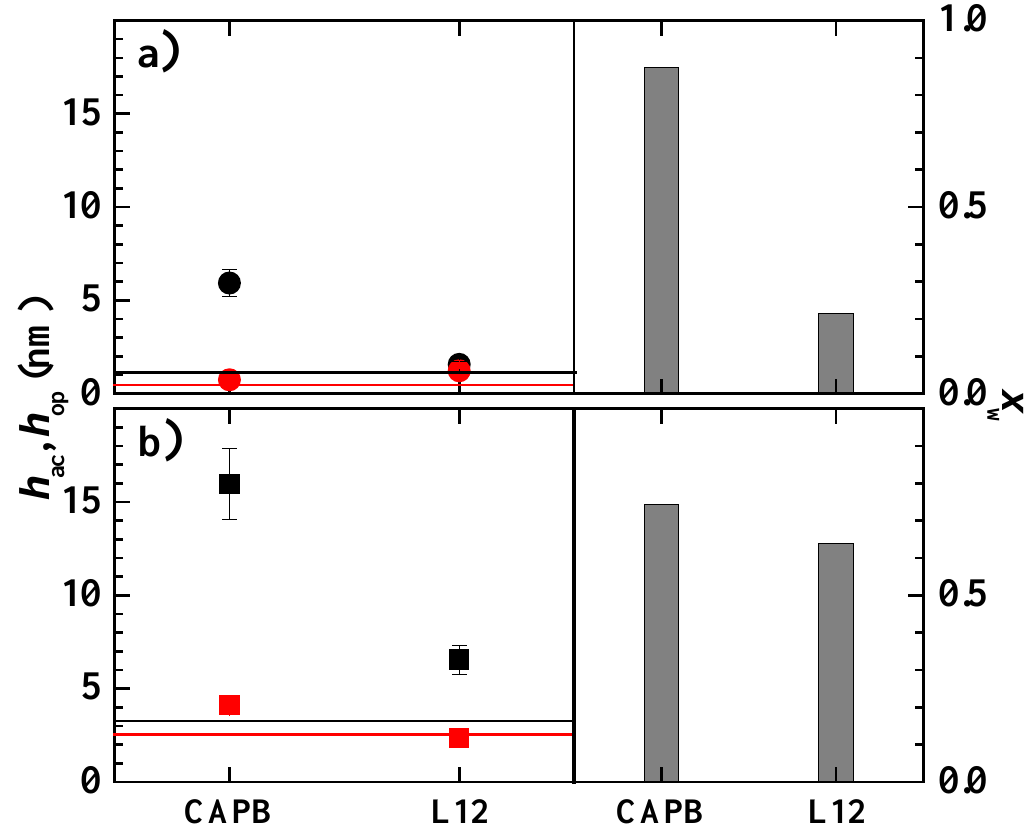
Figure 5. Acoustic ( ■ ) and optical thickness ( ■ ), and water content (bar charts) for the adsorption of pseudo-binary polymer–surfactant mixtures with the same concentration of the components as in Table 2. ( a ) Mixtures with PDADMAC. ( b ) Mixtures with Merquat 2003. Notice that the solid lines represent the acoustic (―) and optical (― ) thicknesses for the adsorption of polymer solutions with the same polymer concentration as that of the polymer–surfactant mixtures.